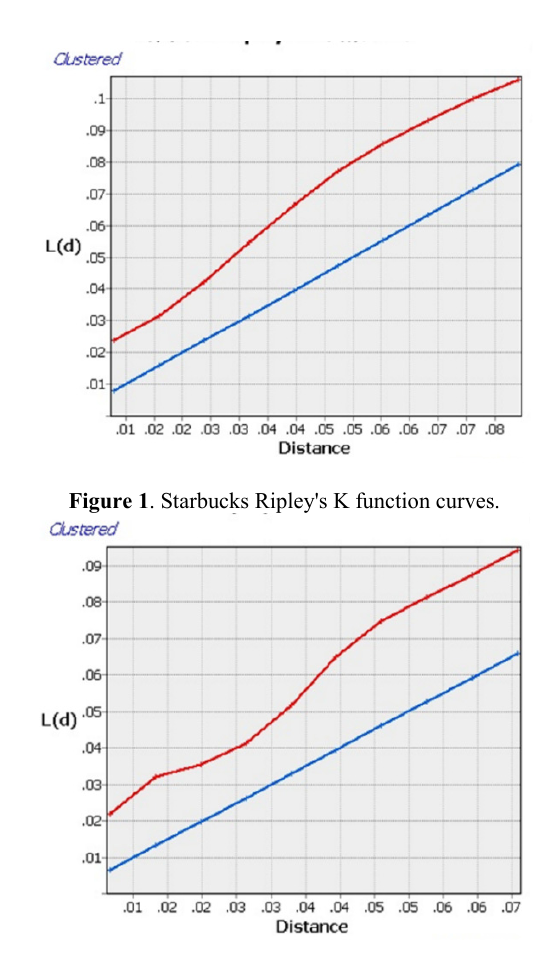
Figure 2 . Luckin Coffee Ripley's K function curves.